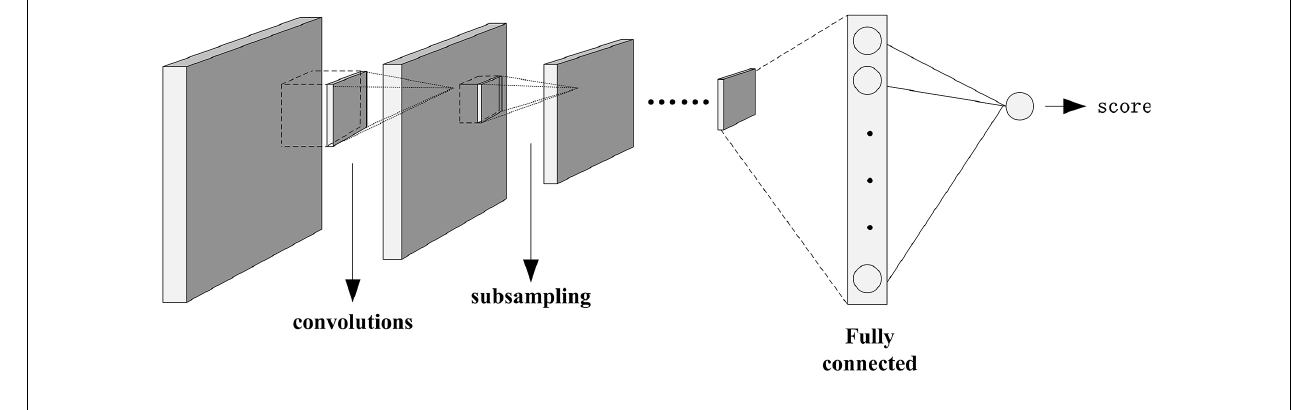
FIGURE 3 | Network architecture of CNN.